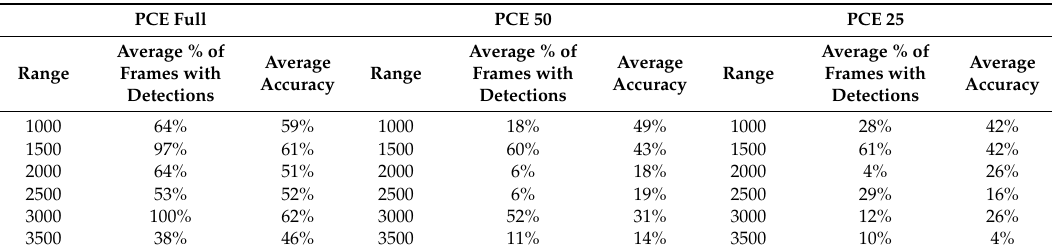
Table 7. Average detection and classification performance of di ff erent MWIR daytime cases. 1500 m and 3000 m were used for